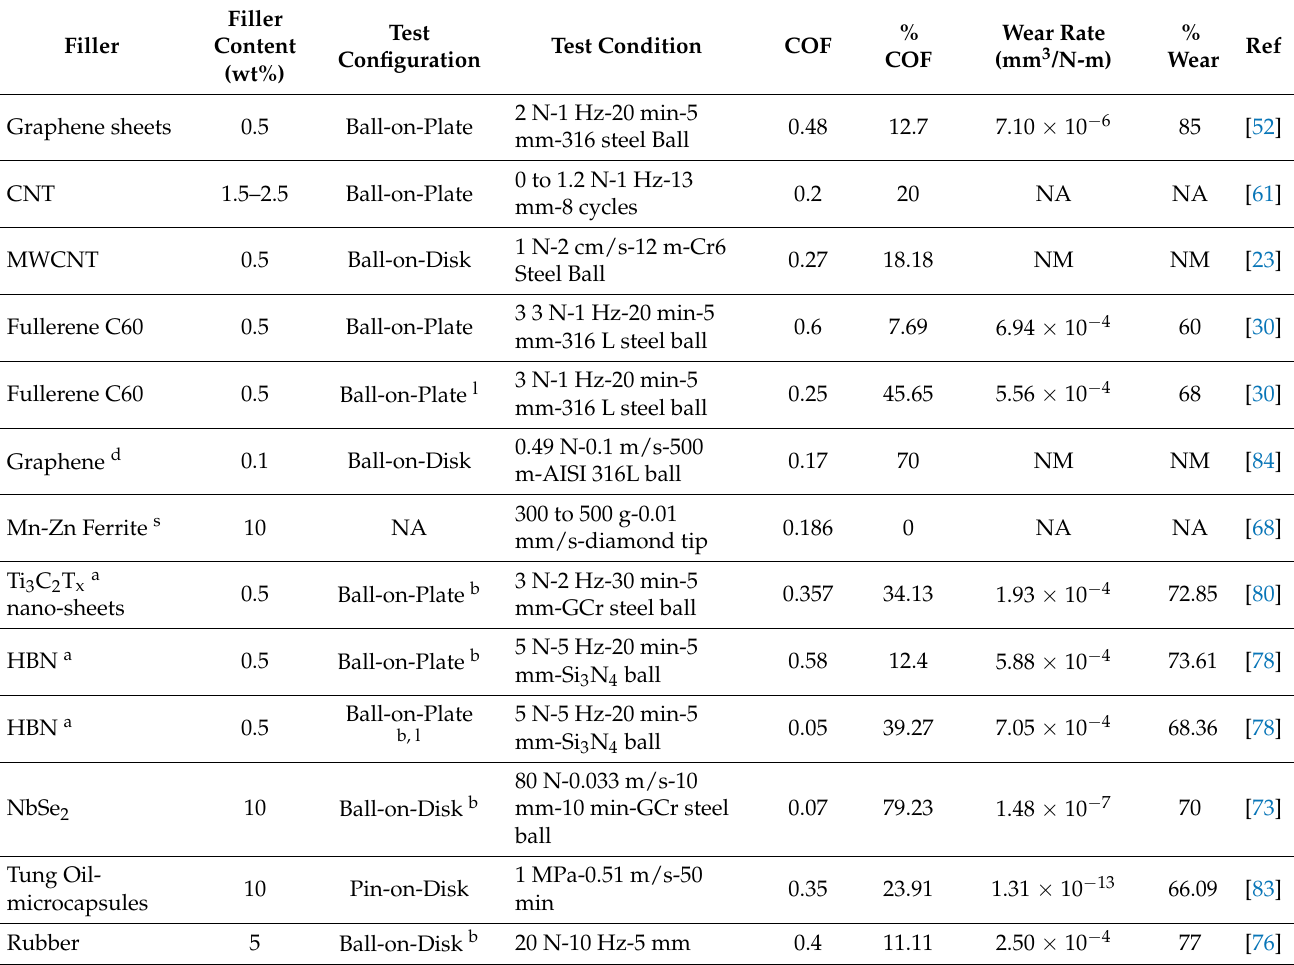
Table 5. Comparison of tribological performance of non-hybrid LBE composite coatings with pristine epoxy coatings.